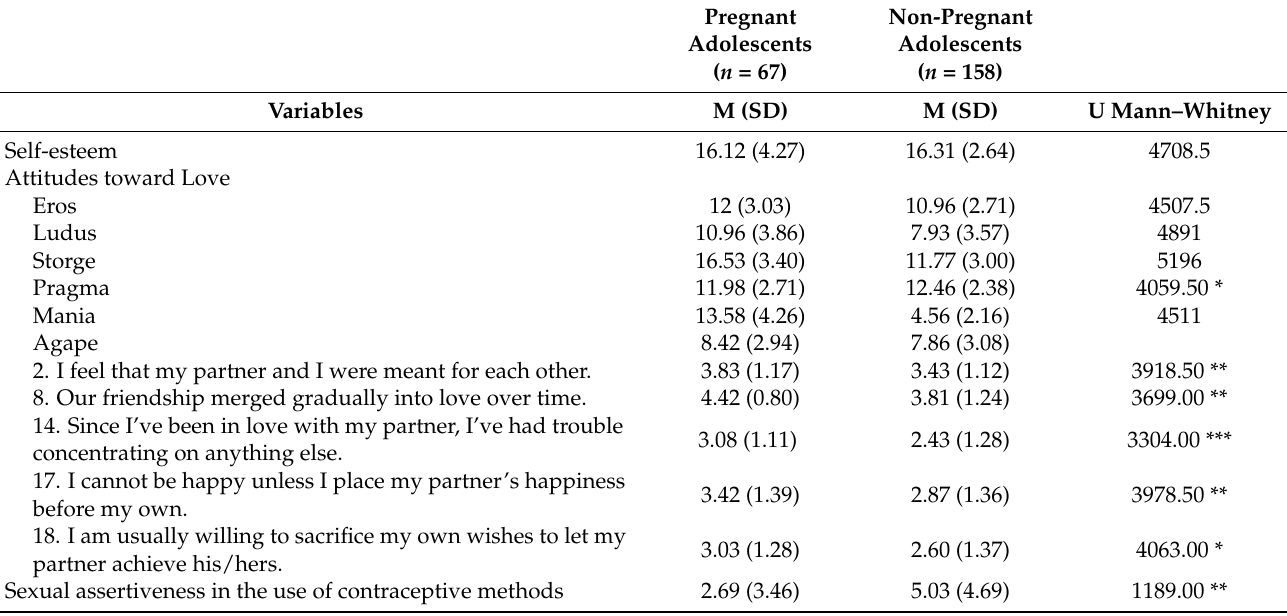
Table 1. Descriptive statistics and comparison in self-esteem. attitudes toward love, and sexual assertiveness between pregnant and non-pregnant